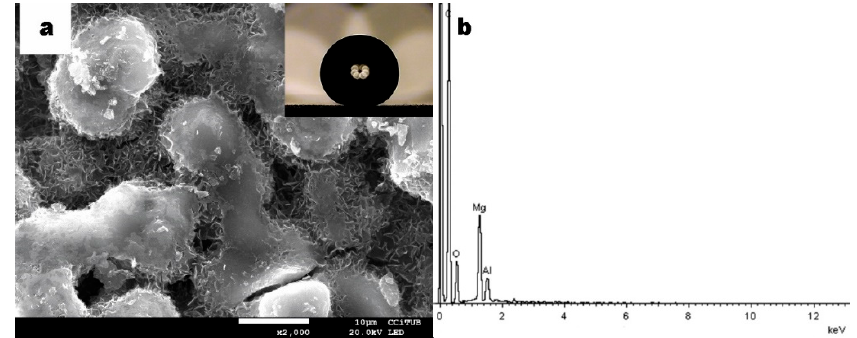
Figure 13. FE-SEM micrograph and EDS spectra shows ( a ) the coating after 10 cycles of abrasive paper test with a smooth structure and ( b ) similar elemental composition after the test is compared to Figure 1c.